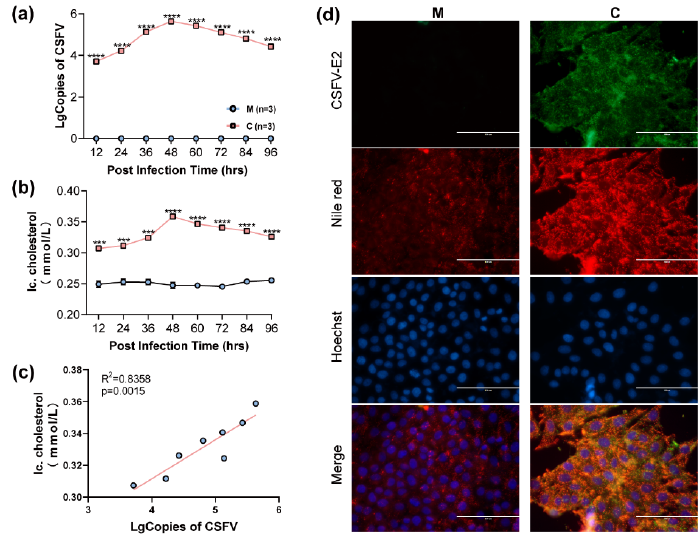
Figure 1. The alterations of intracellular cholesterol in CSFV-infected PK-15 cells. ( a ) CSFV one-step